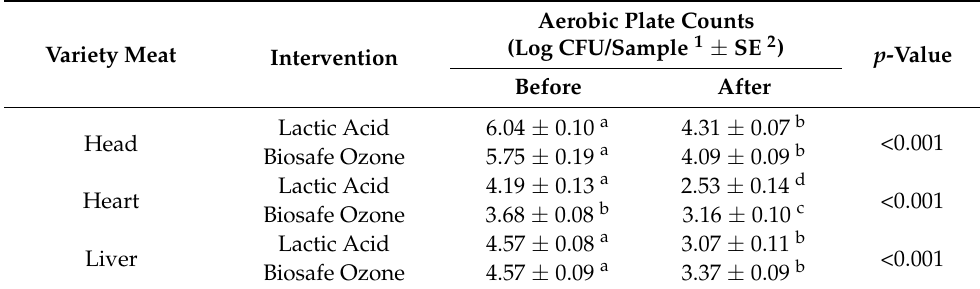
Figure 2. Escherichia coli counts (Log CFU/sample; equivalent to Log CFU/100 cm 2 ) before and after lactic acid and ozone intervention on variety meats (n = 54 per treatment). In each boxplot, the horizontal line crossing the box represents the median, the bottom and top of the box are the lower and upper quartiles, the vertical top line represents 1.5 times the interquartile range, and the vertical bottom line represents 1.5 times the lower interquartile range. a,b For each individual variety meat, boxes with different letters are significantly different according to Kruskal–Wallis analysis followed by pairwise comparison Wilcoxon’s test at P < 0.05. The points represent the actual data points. Table 1. Summary table of aerobic plate counts in all variety meats before and after lactic acid and biosafe ozone